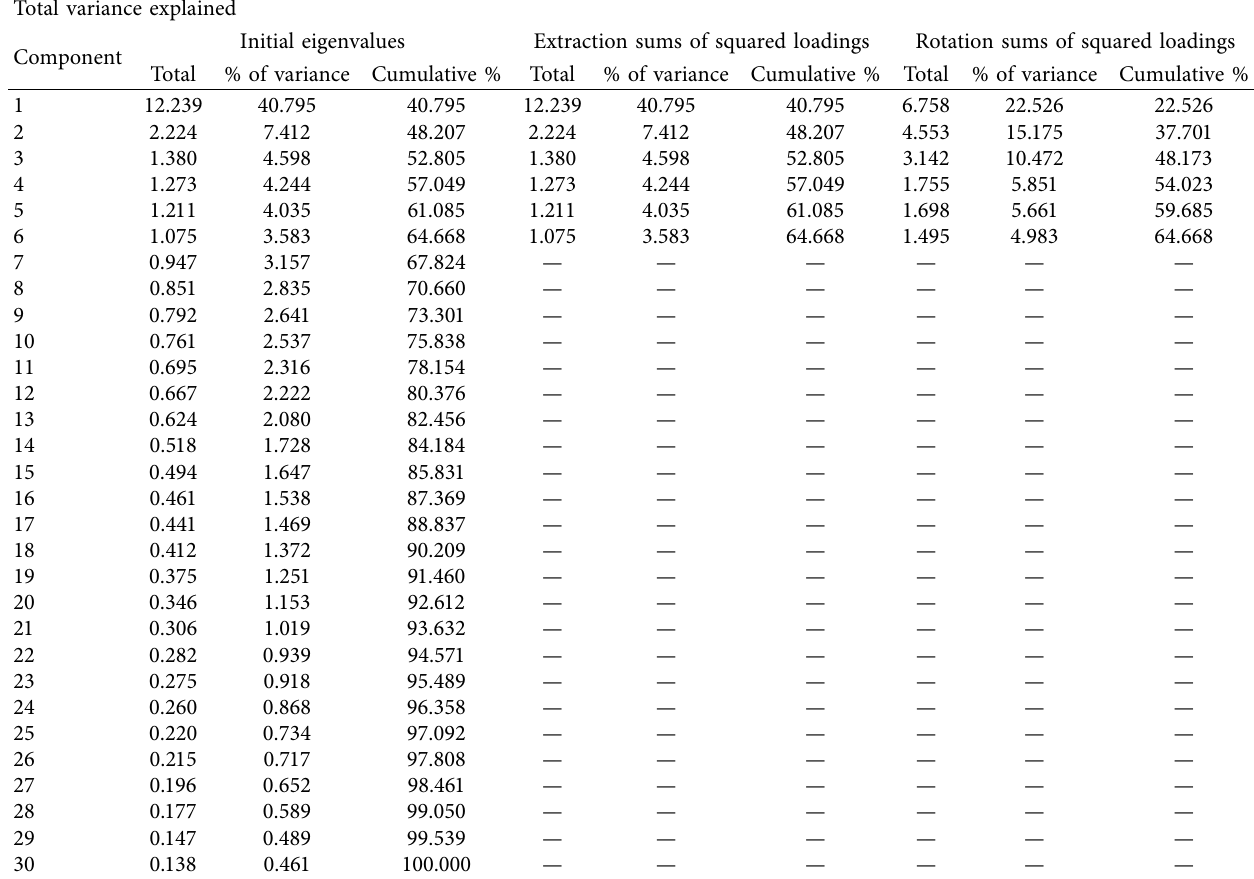
Table 8: Information regarding all components and the common components.